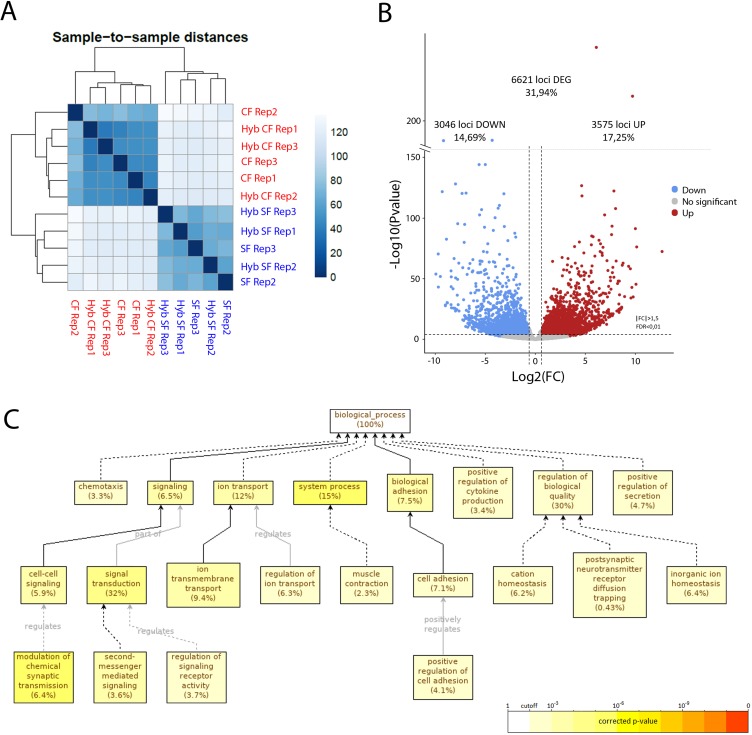
RNA-sequencing of the maternal mRNA of surface fish (SF), cavefish (CF) and reciprocal F1 hybrid (HybSF and HybCF) eggs at the 2-cell stage.(A) Sample-to-sample distance between all samples. Samples that are similar are close to each other. On the scale, lower numbers (dark blue) indicate a closer relationship between samples than higher numbers (light blue/white). (B) Volcano plot of expressed genes at the 2-cell stage (n = 20.730). Genes that have an absolute fold change >1.5 and an adjusted p-value (FDR) <0.01 are considered to be differentially expressed in cavefish compared to surface fish. Genes that are upregulated in cavefish are in red, whereas those that are downregulated in cavefish are in blue. (C) Gene ontology enrichment (level: Biological Process) for cavefish DEGs with an absolute fold change higher than 5. Black lines correspond to ‘is a’ relationship, whereas gray lines correspond to the annotated relationship. Full lines correspond to a direct relationship and dashed lines to an indirect relationship (i.e. some nodes are hidden). The color of a node refers to the adjusted p-value (FDR) of the enriched GO term and the percentage corresponds to the frequency of the GO term in the studied gene set at the level considered. A given gene can have several GO terms. Only enriched GO terms that pass the threshold (p-value<0.01) are displayed on the graph.